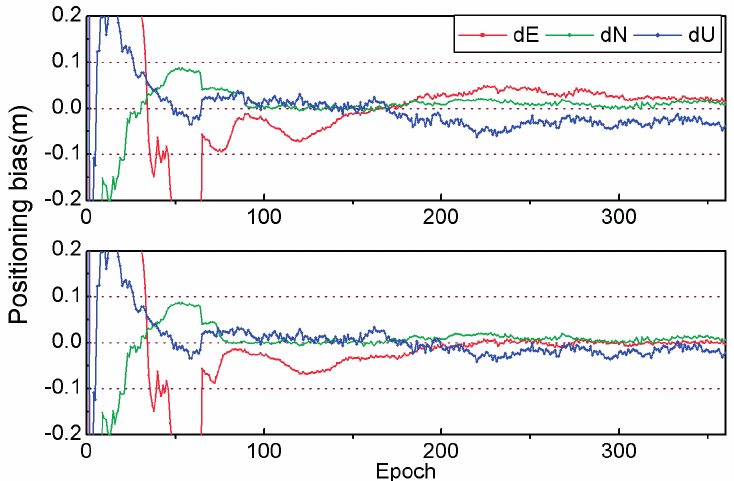
Figure 11. Coordinate biases of kinematic PPP for the observations of the 2nd session from station SANT on 26 January 2012, with respect to the coordinate benchmarks from IGS weekly solutions, with the FAR ( Top ) and PAR ( Bottom ) method, respectively.